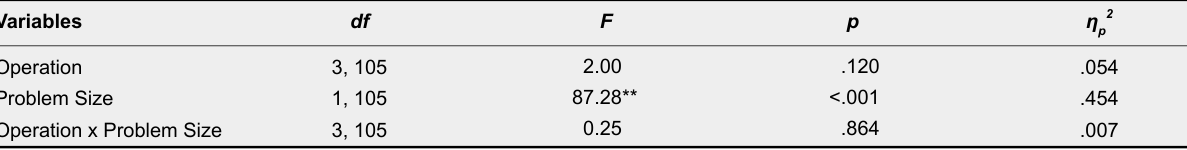
Statistical Analysis of Residual Response Time as the Percentage of Total